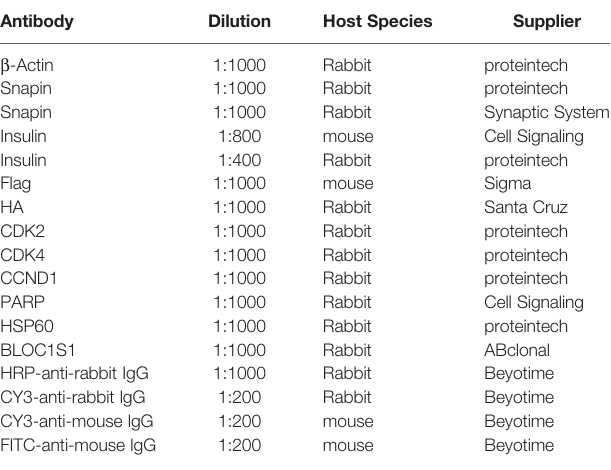
TABLE 3 | Antibodies used in Western blotting, immunohistochemistry and immuno fl uorescence.